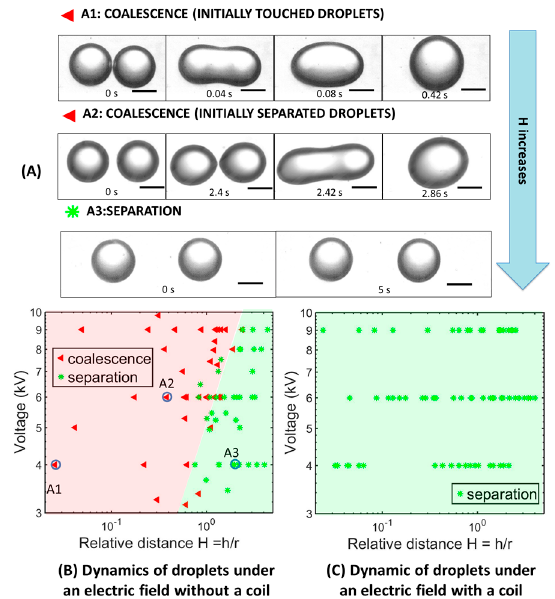
Figure 3. ( A ) Dynamic behaviors of droplets in an electric field: ( A1 ) Coalescence of two touching droplets; ( A2 ) Coalescence of two droplets which are slightly separated; ( A3 ) Separation of two droplets. Scale bars are 300 μ m. At t = 0 s, a high voltage is applied with an intensity of: 4 kV ( A1 , A3 ); 6 kV ( A2 ). Dynamic behaviors of droplets in the device ( B ) without a coil and ( C ) with a coil, under different applied voltages and relative distances, H .